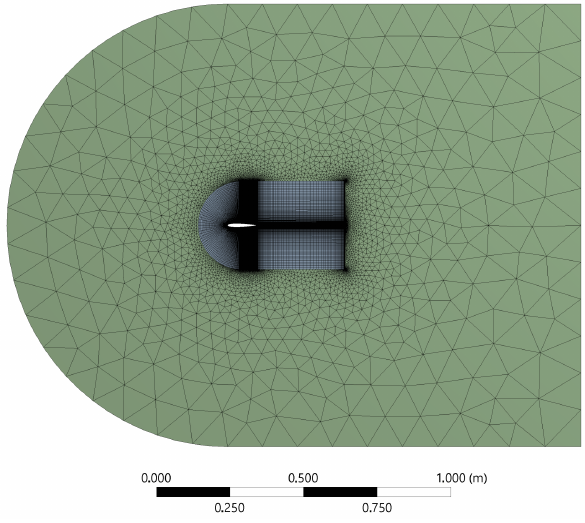
Figure 1. Computational mesh